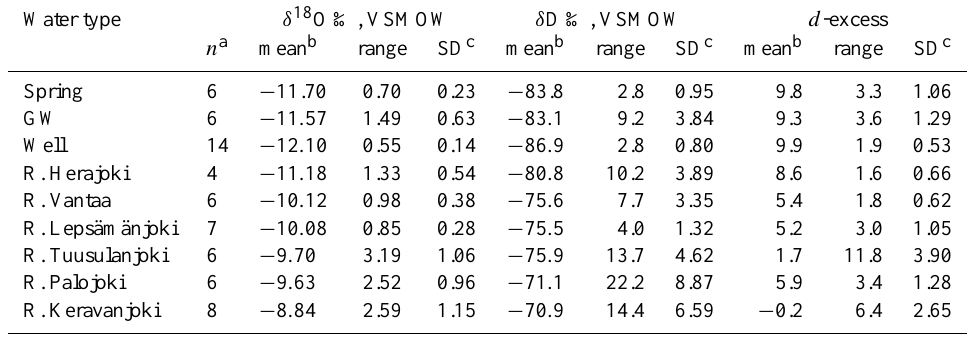
Table 3. The mean, range and standard deviation of δ 18 O, δ D and d -excess values of water samples in summer 2011.